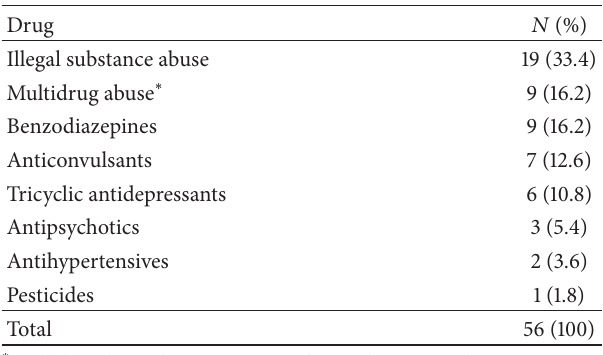
Table 1: Frequency distribution of agitation with respect to the ingested toxin in studied